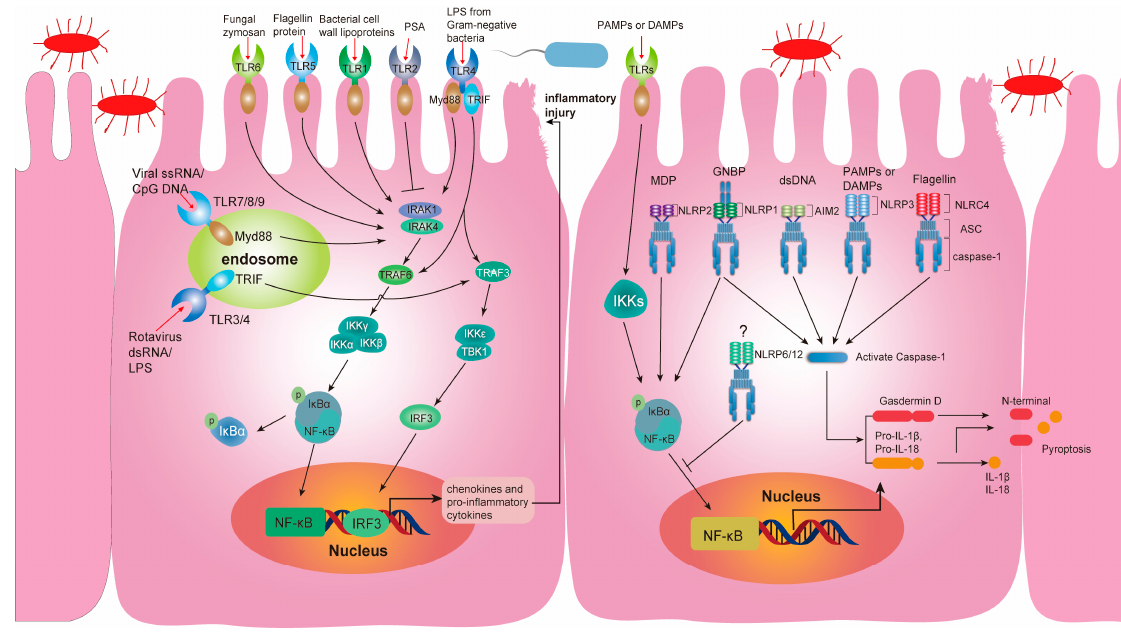
Figure 3. Diagram showing the activation pathways of toll-like receptors (TLRs) and NOD-like receptors (NLRs) in the intestinal epithelial cells. Intestinal epithelial cells (IECs) express multiple pattern recognition receptors (PRRs) including TLRs and NLRs, which can recognize pathogen-associated molecular patterns (PAMPs) and damage-associated molecular patterns (DAMPs). TLRs are present in cell membranes and endosomes. When TLRs sense PAMPs or DAMPs, they can recruit signaling adaptors (myeloid differentiation factor 88, MyD88) and then initiate a signaling cascade in MyD88 dependent mechanism, eventually causing the transcriptional activation of nuclear factor kappa-B (NF- κ B). TLRs can also be activated in the MyD88 independent mechanism that involves TIR-domain-containing adaptor protein inducing interferon- β (TRIF). Canonical activation of NLR family pyrin domain-containing proteins (NLRPs) requires two signals. Signal 1 is activated by PAMPs or DAMPs through TLRs for the upregulation of pro-IL-18 and pro-IL-1 β . Signal 2 involves the sensitization of NLRs and the assemble of inflammasome, which further induces the activation of caspase-1 to cleave pro-IL-18, pro-IL-1 β , and Gasdermin D. Eventually, IL-18, IL-1 β , and Gasdermin D N-terminal domain induce cell pyroptosis. TRAF: TNF receptor-associated factors; IRAK: IL-1R- associated kinases; IKK: inhibitor of NF- κ B kinase; I κ B α : inhibitor of NF- κ B α ; IRF: interferon- regulatory factors; TBK1: TANK-binding kinase 1; PSA: Polysaccharide A; ssRNA: single-stranded RNA; dsRNA: double-strand genomic RNA; CpG DNA: CpG-rich hypomethylated DNA motifs in microbial genome; GNBP: Gram-negative bacterial peptidoglycan; MDP: muramyl dipeptide.